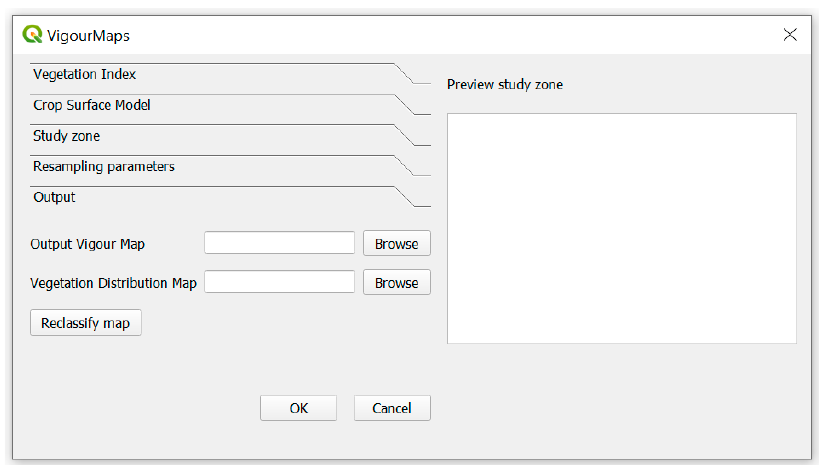
Figure 2. Main window of the QVigourMaps graphical user